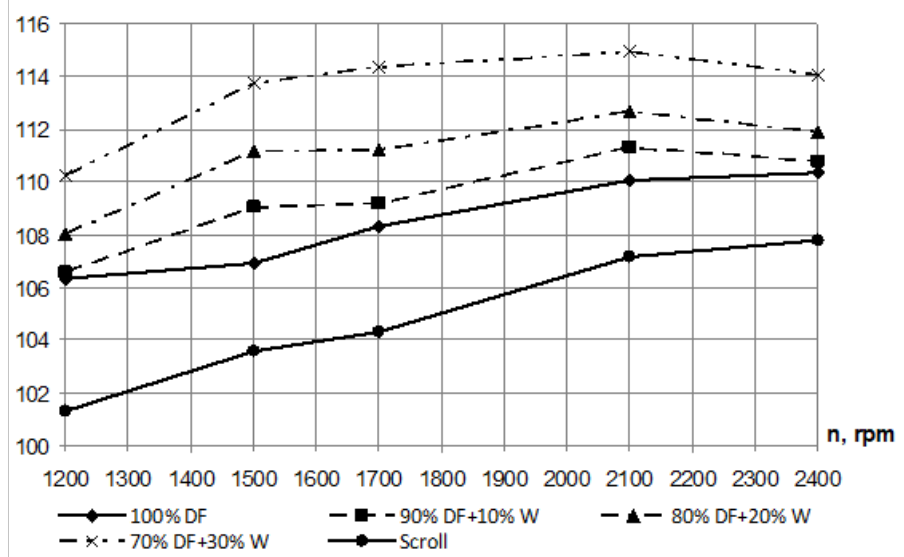
Figure 8. Overall noise levels of the engine when working on diesel fuel and water–fuel emulsions.